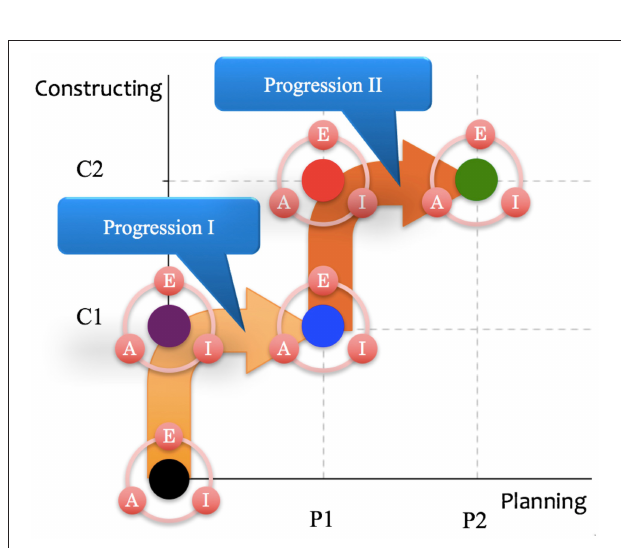
FIGURE 4 | Framework for developing an explorative proving curriculum.